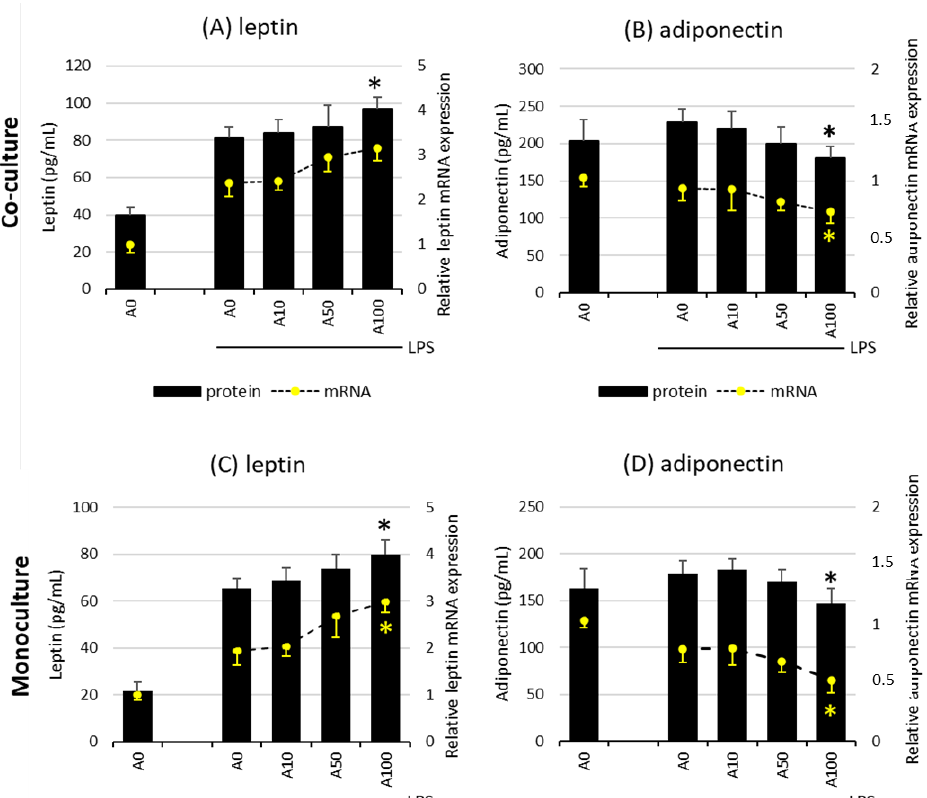
Figure 4. Effects of asprosin on LPS (100 ng/mL)-induced leptin expression and release ( A ) or adiponectin expression and release ( B ) by adipocyte–macrophage cocultures at 21 days of differentiation and leptin expression and release ( C ) or adiponectin expression and release ( D ) by adipocyte monocultures at 21 days of differentiation. 3T3 L1 adipocytes and RAW 264.7 macrophages were cultured in 12-well dishes with inserts (0.4 µ m pore size) for 6 h (mRNA expression, rt-PCR) or 24 h (adipokine release, ELISA tests) with or without asprosin (0, 10, 50, or 100 nM; A0, A10, A50, or A100, respectively). The results are expressed as mean + standard deviation (SD) from five independent experiments. Statistical significance ( p < 0.05) was determined by the Duncan t -test. The asterisk (*) above the bar denotes statistically significant differences in protein or mRNA levels, calculated relative to the A0 + LPS control group.